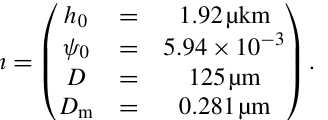
Figure 10. Optimised dimensional deposit output from the model with both mud and sand sediment classes, e η 2 , shown against the optimised results from the single sediment class model, e η , the field measurement from Bed 1.1 (Talling et al., 2007a), and the fourth- order polynomial target deposit profile, η T